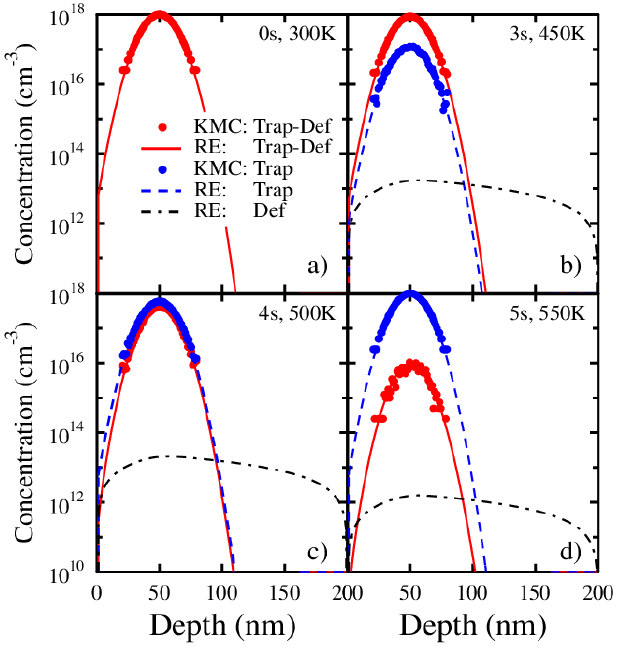
Figure 4. The depth profiles for the KMC and RE simulations at four different times and temperatures during the TDS simulation. At the beginning, at time 0 s, ( a ) the temperature is 300 K, and there is only the filled trap profile (Trap-Def). The temperature increases linearly with time (50 K/s) and at 3 s, ( b ) some defects (Def) have detrapped, leaving empty traps (Trap). At 4 s, ( c ) there are more empty than filled traps, and at 5 s, ( d ) only a few filled traps are left. Note that the number of defects (Def) for the KMC simulation are too few to determine any meaningful defect depth